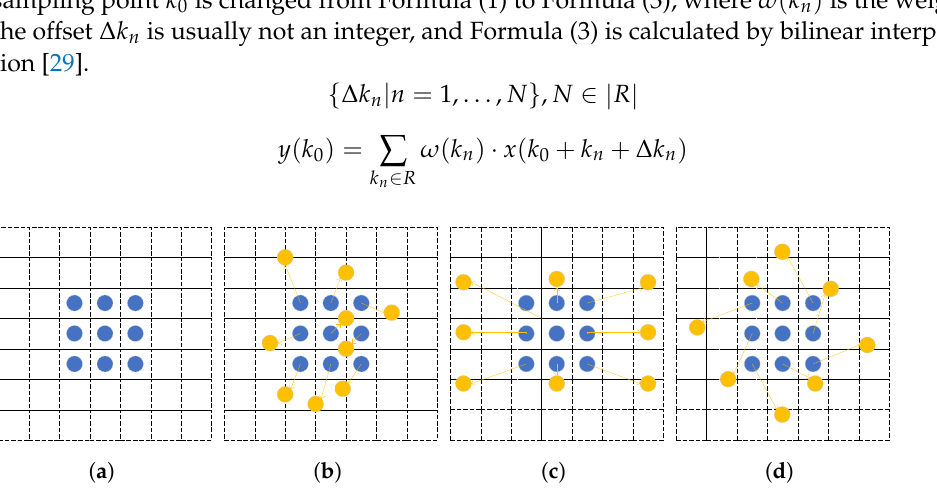
Figure 4. Comparison of conventional convolution and deformable convolution: ( a ) conventional convolution; ( b ) deformable convolution; ( c ) special case 1; ( d ) special case